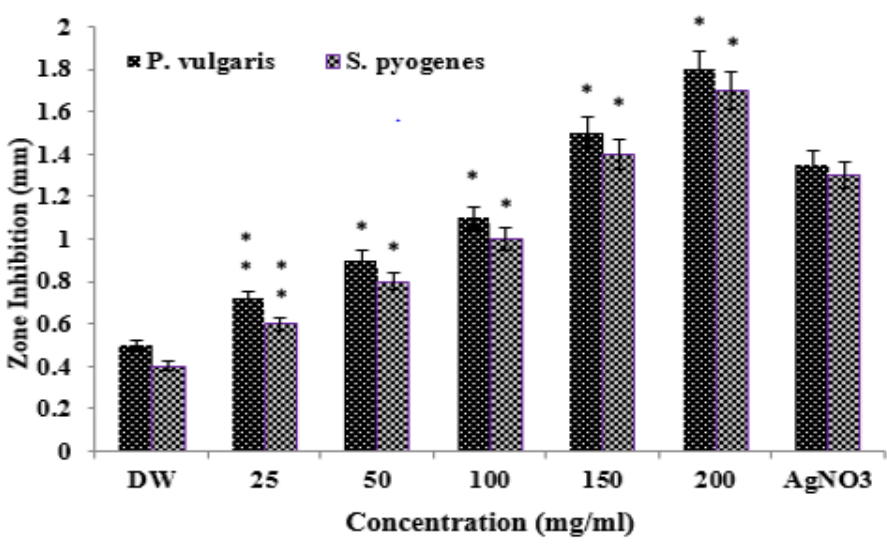
O -NPs against P.vulgaris and S.pyogenes . mean ± SD are presented for 2 3